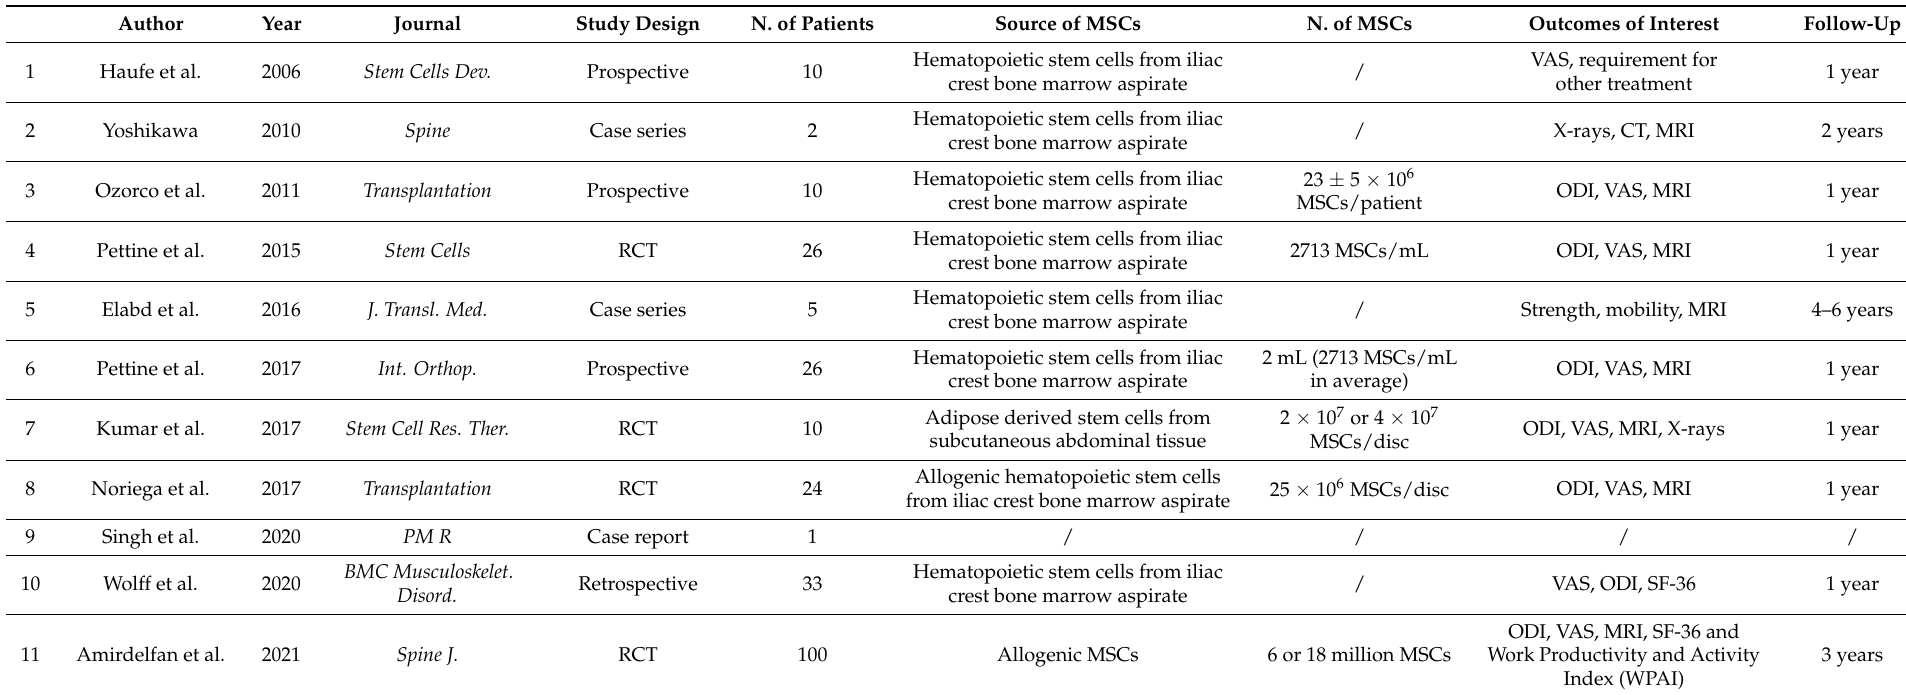
Table 1. Summary of the characteristics of the available studies. MSC: mesenchymal stem cells; VAS: visual analogic scale; ODI: Oswestry Disability Index; SF-36: Short-Form 36; MRI: magnetic resonance imaging; CT: computed